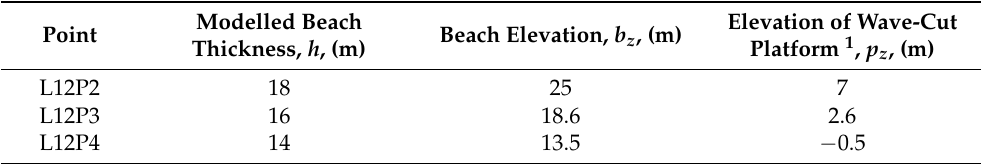
Figure 9. Single station H/V observed and modelled at the three nearest stations to the dune MASW location. The labels L12P2-4 indicate the points 2, 3, and 4 on line 12. The right panels show the single component spectra as solid blue, green, and magenta lines. The left panels showed the averaged H/V as a solid red line, with the standard deviation as thinner black lines. The modelled or synthetic spectra are shown as a blue line and the main model parameters are shown as text. Table 2. Estimated elevation of the wave-cut platform calculated from beach elevation minus beach elevation at points 2, 3, and 4 on line